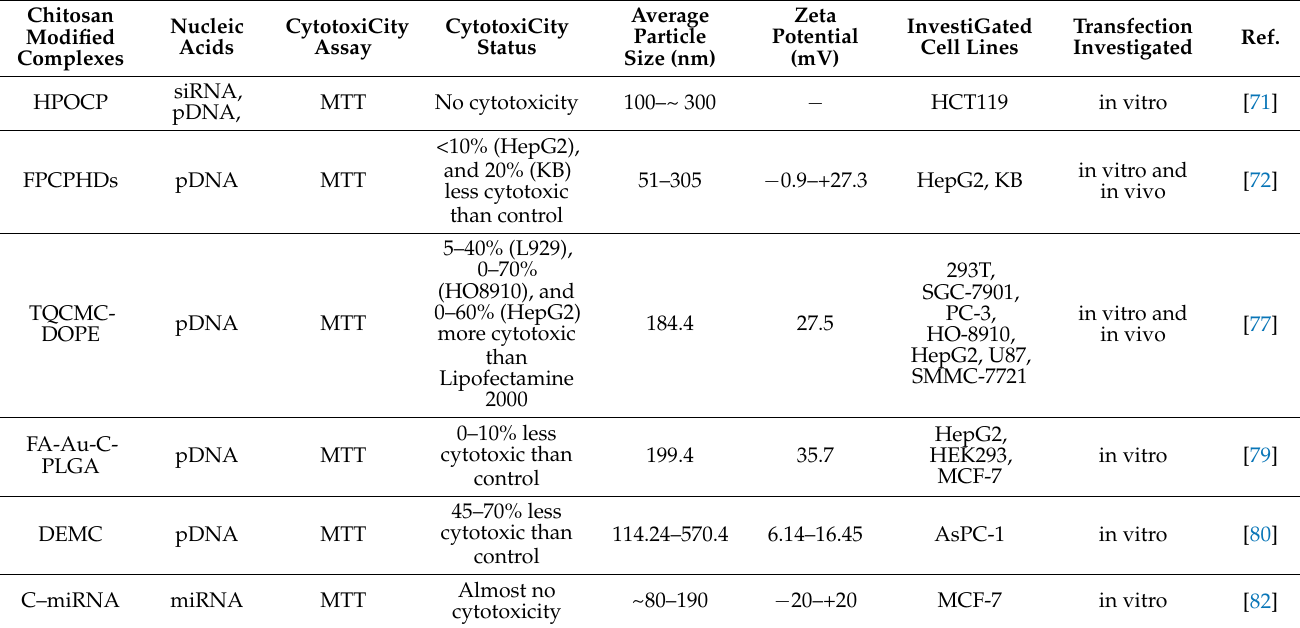
Table 2. Physicochemical properties and transfection report of some chitosan-based complexes. Chitosan